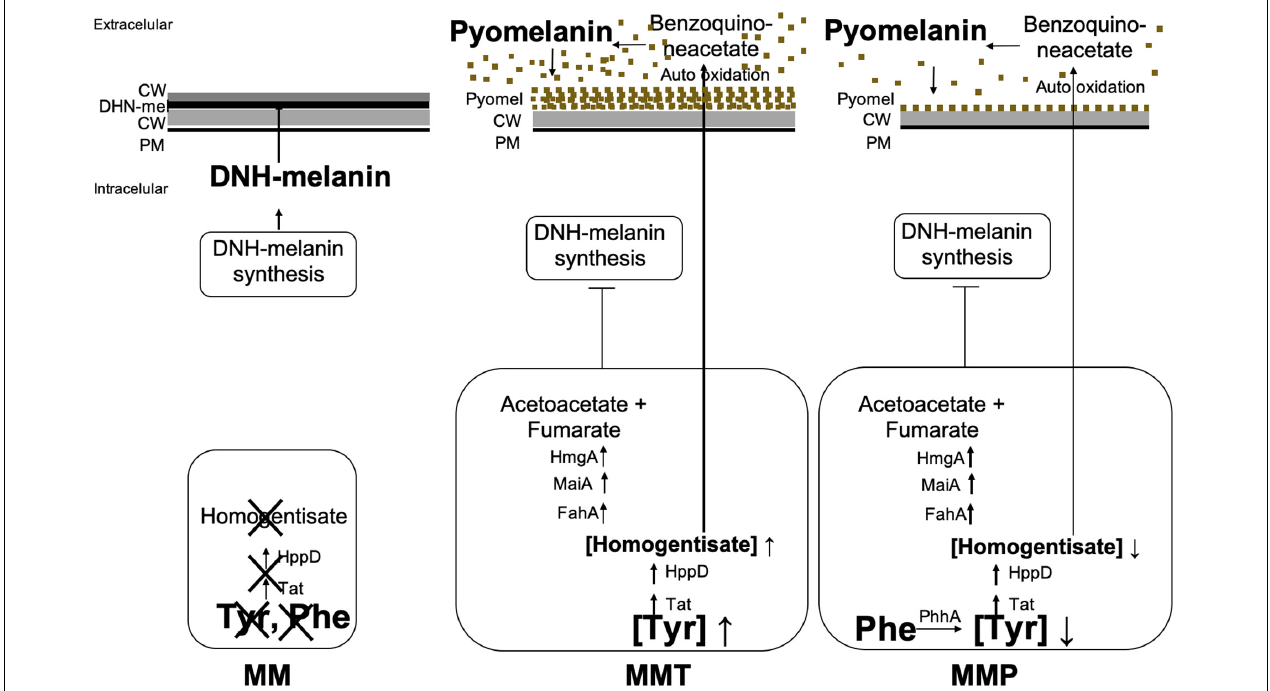
FIGURE 9 | Regulation of pyomelanin synthesis in A. alternata . Here, we report that when A. alternata is grown in MM medium, no precursor of HGA is present, thus there is no formation of pyomelanin and the DHN-melanin pigment is formed. In MMT medium, L-tyrosine leads the production of large concentrations of HGA that accumulates in the cell and is released into the medium leading to the formation of pyomelanin. There is inhibition of DHN-melanin synthesis. The fungus turns brown. In MMP medium, L-phenylalanine, a L-tyrosine precursor is progressively converted into L-tyrosine by PhhA and also leads to the formation of HGA, but to a lower extent than with L-tyrosine supplemented into the medium. This is probably due to the progressive conversion of L-phenylalanine into L-tyrosine. As L-tyrosine is formed, it is converted into hydroxyphenylpyruvate that is then converted into HGA. This compound is degradated into fumarate and acetoacetate (catabolism of L-tyrosine pathway) leading, consequently to low HGA accumulation and efflux out of the cell and low pyomelanin formation. The DHN-melanin synthesis is inhibited leading to an albino-like